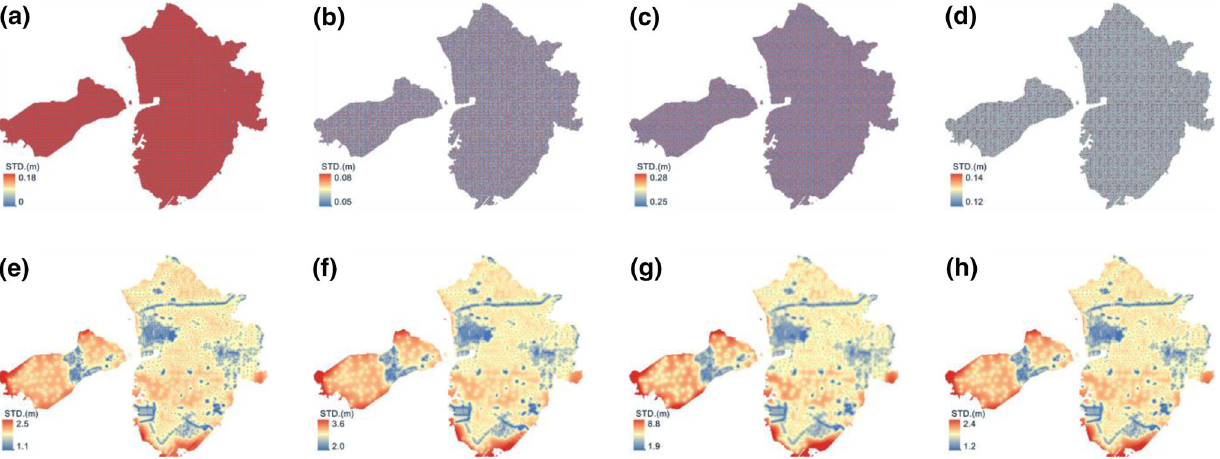
Fig. 6 The Incheon and Bucheon study areas in South Korea: Spatial comparison of standard deviations according to the conventional method and the proposed optimization method by using a geo-data dataset and multiscale grid-based ordinary kriging: a multiscale grid- based fill; b multiscale grid-based alluvial soil; c multiscale grid-